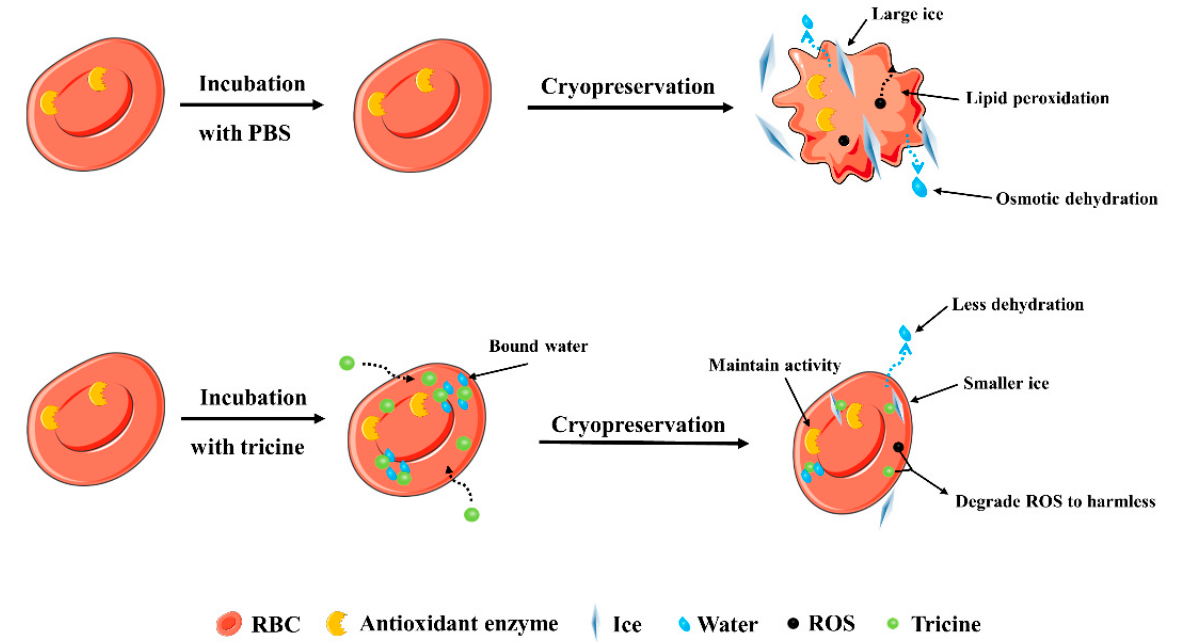
Figure 7. The proposed mechanism of tricine in cryopreservation.